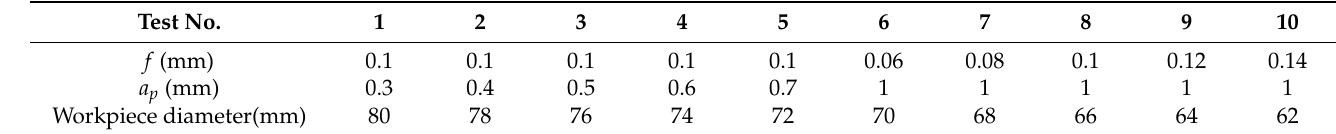
Table 6. Cutting